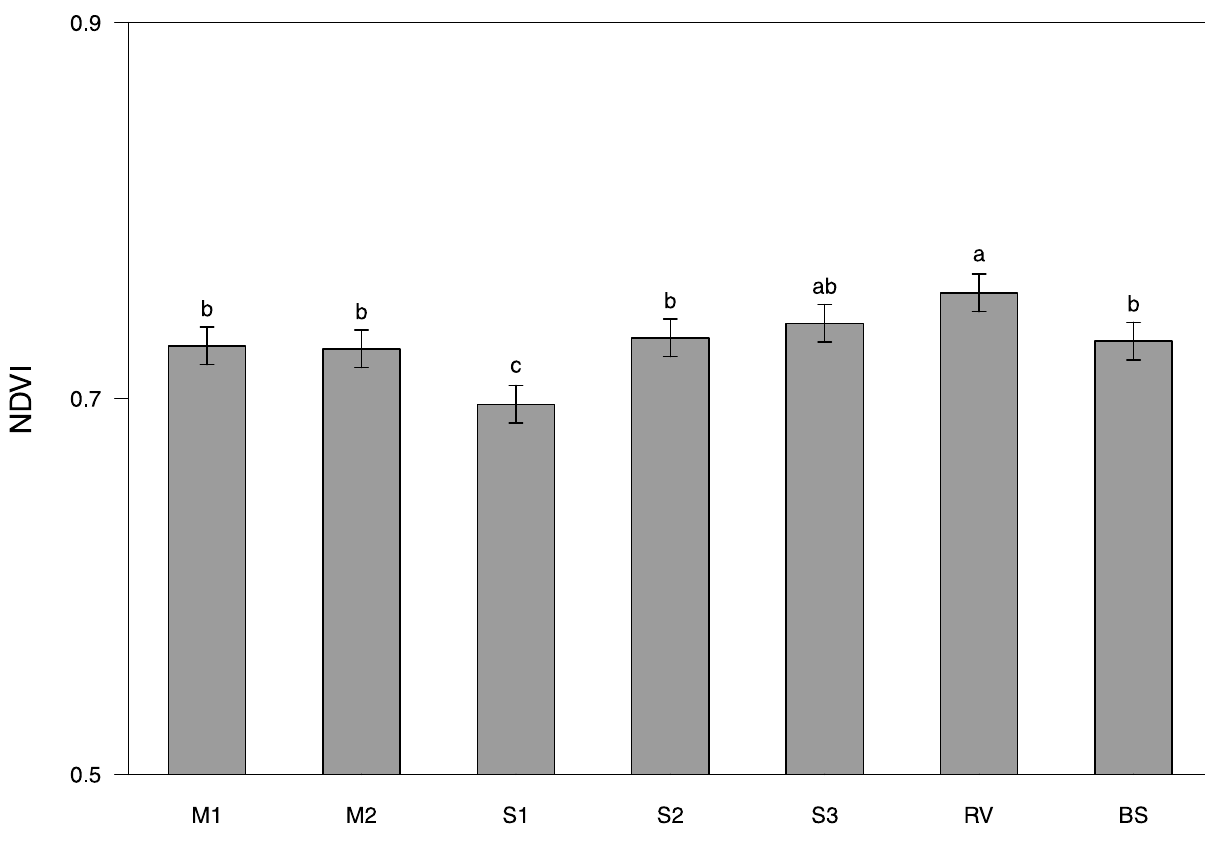
Fig 7. Effects of type of inter-row vegetation (M1 = grass-legume mixture 1, M2 = grass-legume mixture 2, S1 = Schenodorus aundinaceus blend, S2 = Lolium perenne blend, S3 = Festuca rubra blend, RV = resident vegetation) and bare soil (BS) on the NDVI values of the vine rows. Values with the same letter are not significantly different (LSD test at a 0.05 probability level).